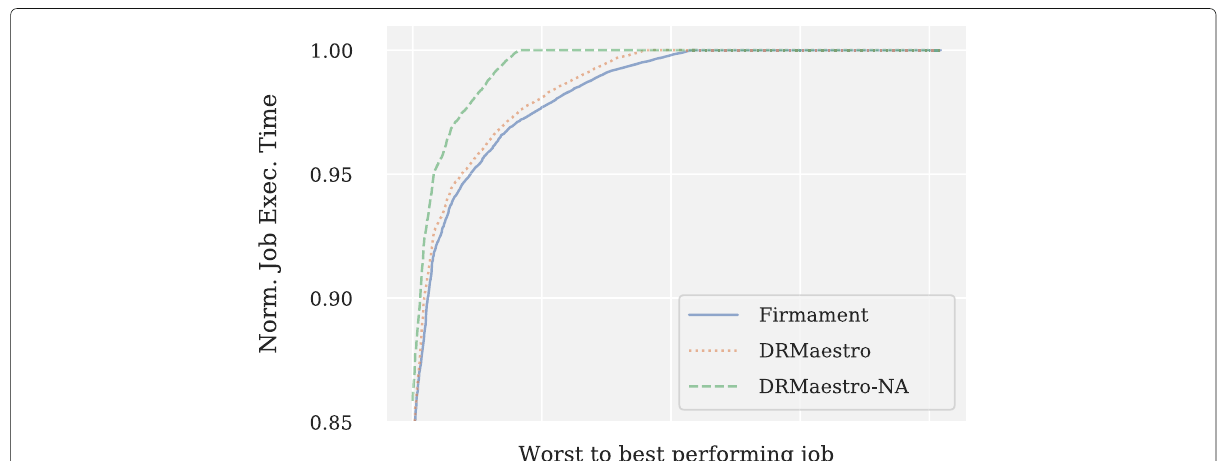
Fig. 10 Job’s QoS. Normalized job execution time for the scheduling policies with and without network awareness, ordered from worst to best. For a scenario with ≈ 4k jobs and 128 machines